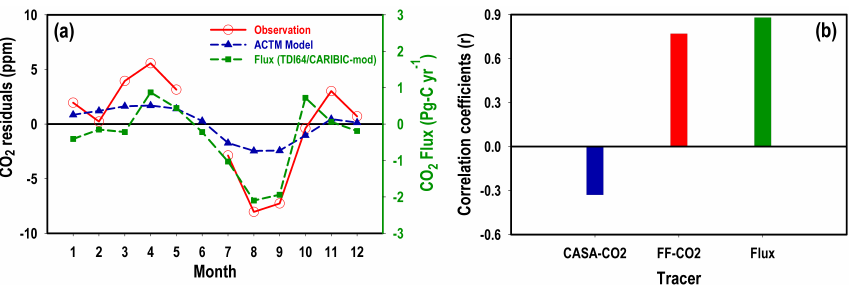
Figure 11. (a) The red circles and blue triangles show the mean seasonal cycles of CO 2 (inppm) using afternoon values only, calculated from measurements over Ahmedabad and the model. The green triangles show the seasonal cycles of CO 2 flux over southern Asia, calculated from TDI64/CARIBIC-modified inverse model as given in Patra et al. (2011) (Fig. 3d). (b) Blue bar and red bar show the correlation coefficient ( r ) of model CO 2 concentration of biospheric tracer and fossil fuel tracer component with observed concentrations of CO 2 , taking the entire annual time series of daily mean data. The green bar shows the correlation coefficient between the monthly residuals of afternoon mean only and the CO 2 flux over southern